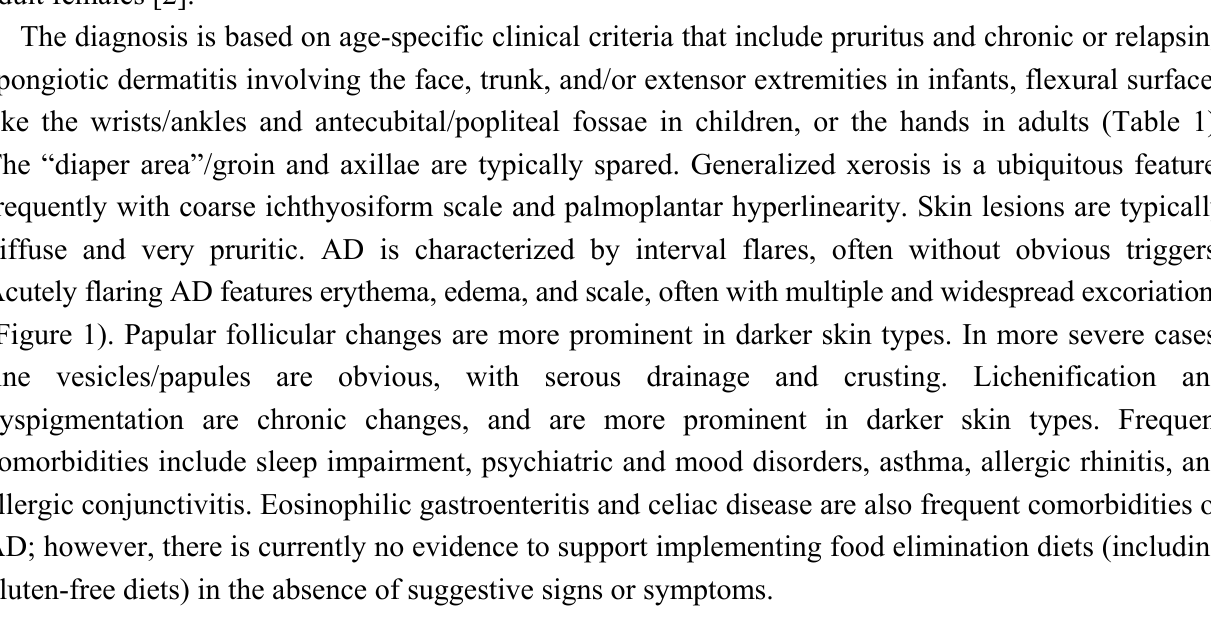
Table 1. American Academy of Dermatology (AAD) Diagnostic Criteria for